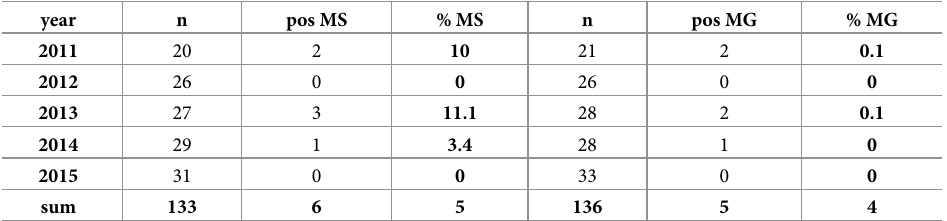
Table 4. Number of serum samples tested positive for antibodies against Mycoplasma synoviae (MS) and Myco- plasma gallisepticum (MG) during spring sampling. Only trapped pheasants were